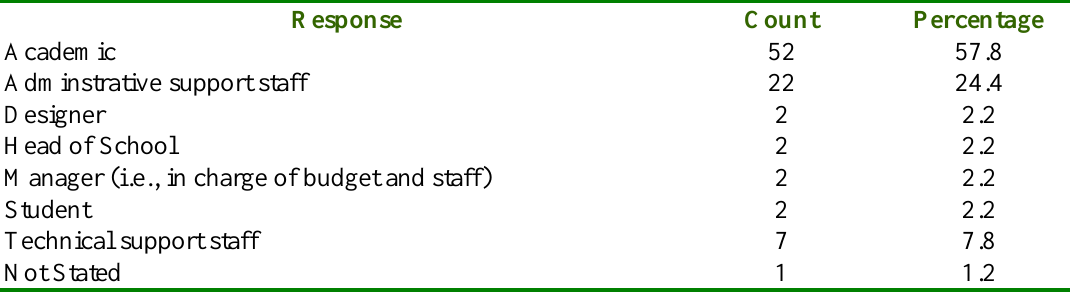
Table 2. Respondents’ Current